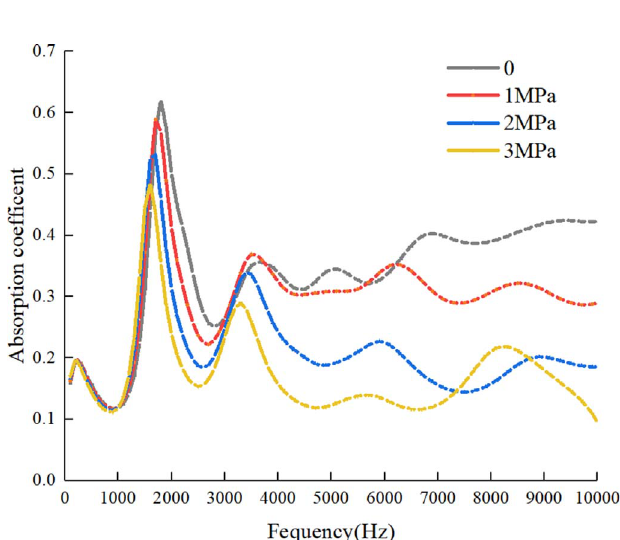
Figure 11. Sound absorption coef fi cient under different static pressures.